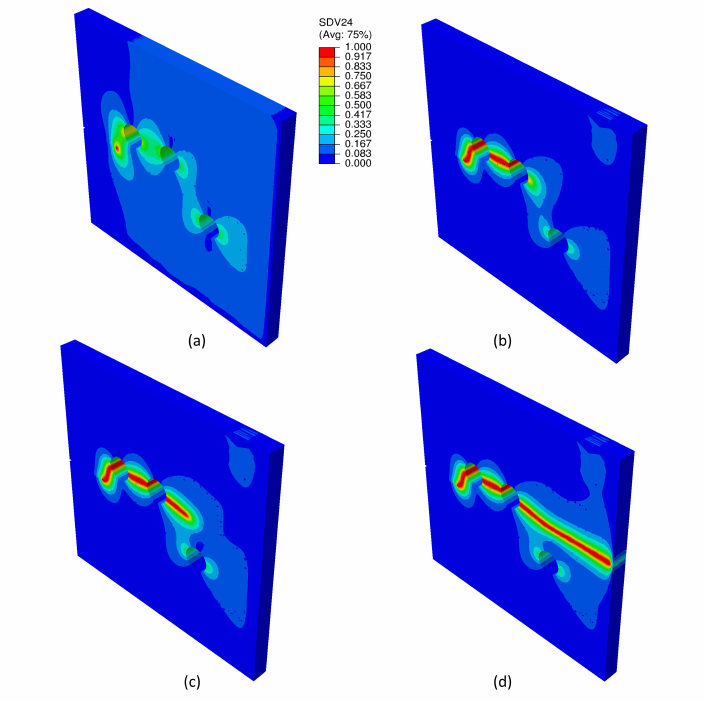
Figure 11. Crack propagation steps for higher incremental step size: ( a ) crack propagation after 100 steps ( b ) crack propagation through holes; ( c ) slight bend in path due to damage zone influence of hole below; and ( d ) propagates along straight path.